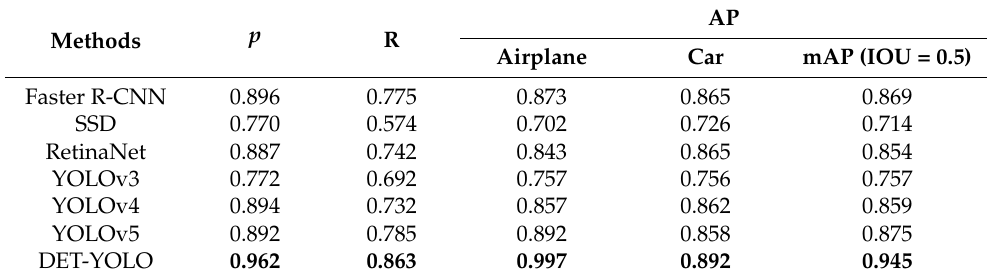
Table 5. Comparison of the performances of various models on the UCAS-AOD